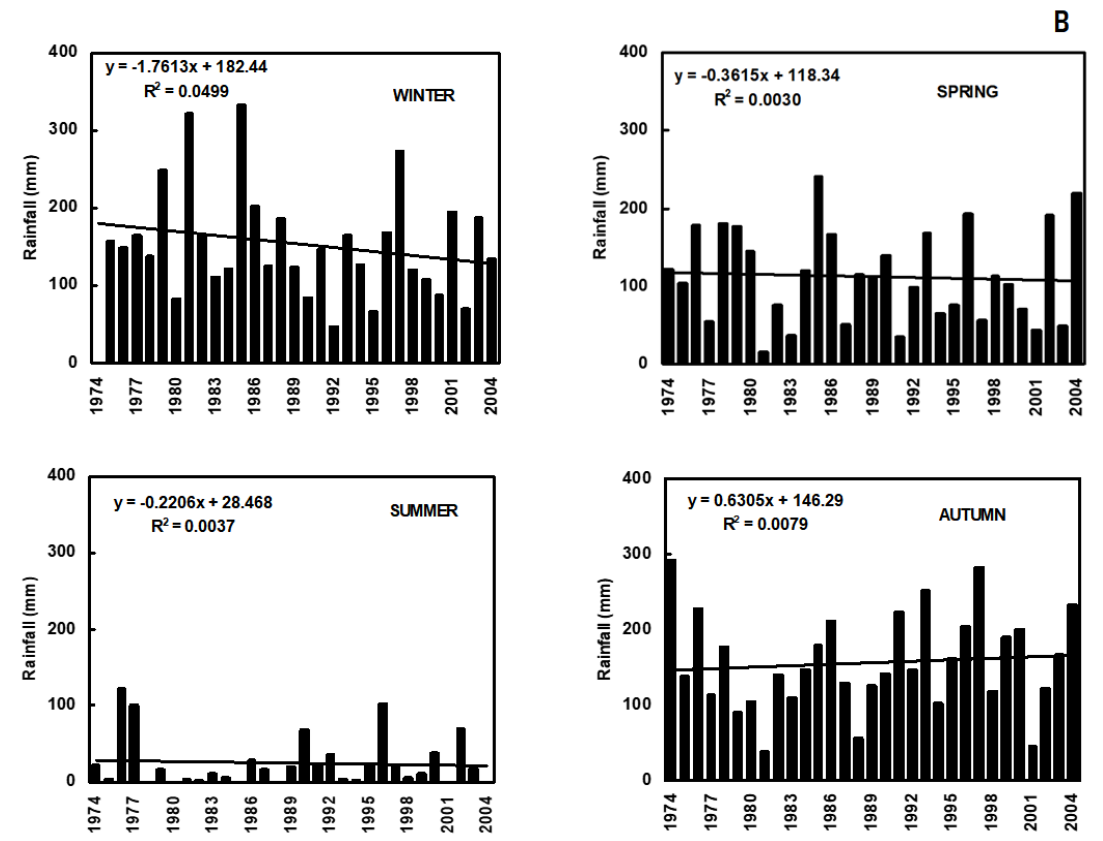
Figure 2. Annual ( A ) and seasonal ( B ) trends of rainfall over the period 1974–2004 at the AGRIS experimental station “S. Michele” (Southern Sardinia, Italy).